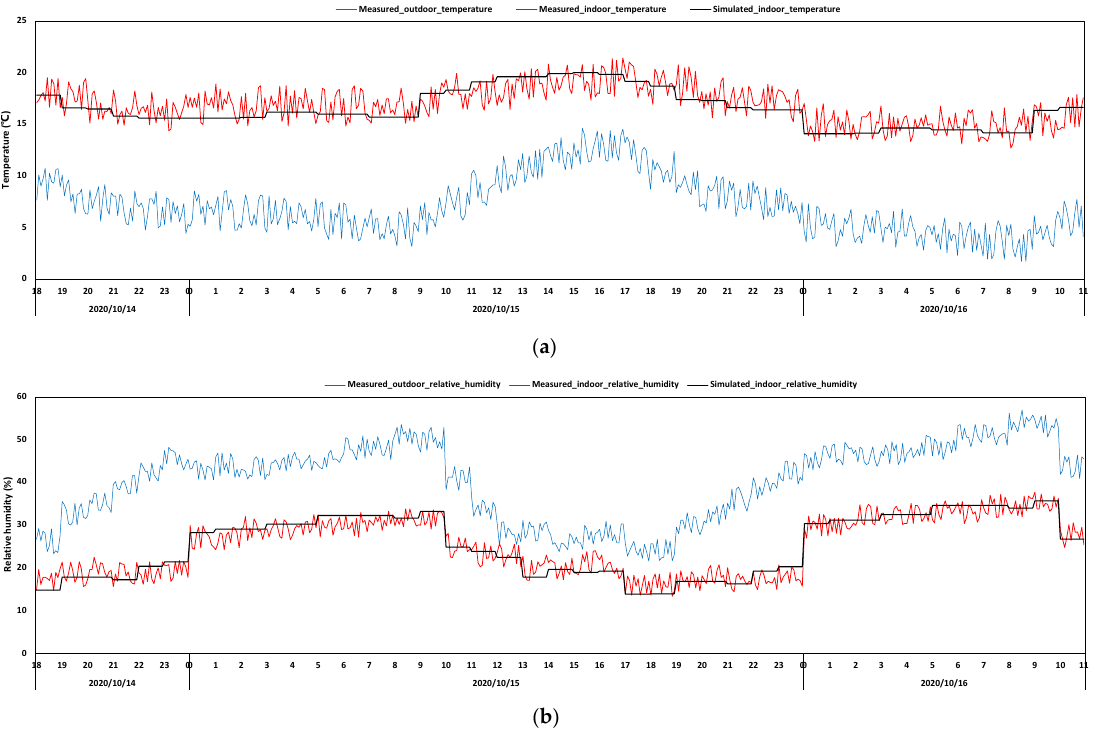
Figure 8. Comparison between measured and simulated data: ( a ) Temperature; and ( b ) Relative humidity).